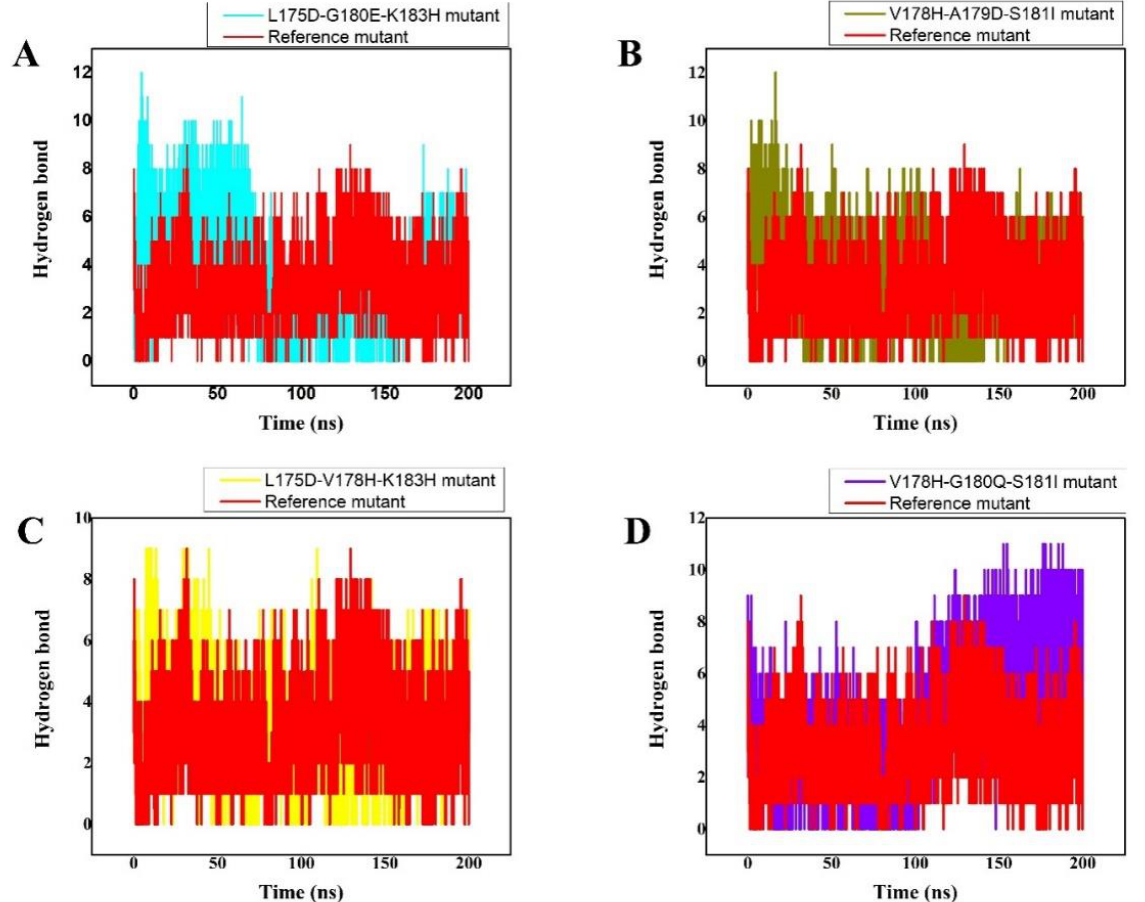
Figure 3. ( A – D ) The total number of Hydrogen bonds over 200 ns MD trajectory, the x -axis shows the time duration in nano second while the y -axis represents the number of hydrogen bonds. The total number of intermolecular H-bond interactions between K-Ras and the peptide variants. The different colours show the different designed peptides/K-Ras mutant complexes while the reference peptide/K-Ras mutant is shown in red.